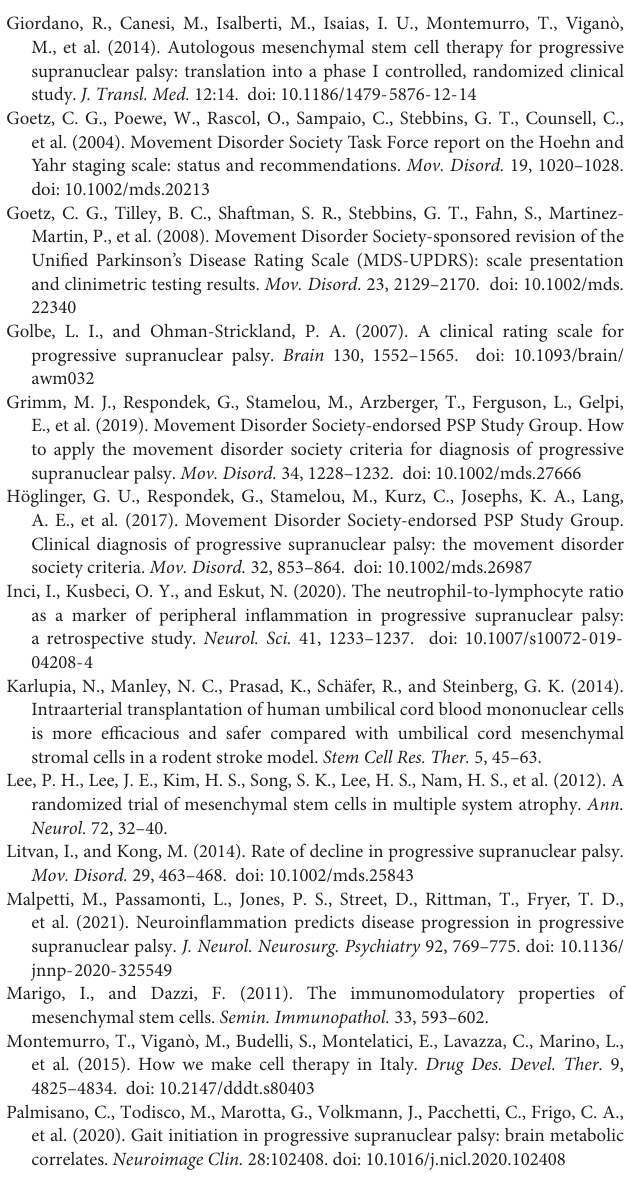
Supplementary Figure 1 | Serum cytokine levels in PSP patients before and after MSC administration. Dot plot diagrams comparing serum concentrations for each cytokine (Wilcoxon matched-pairs signed-rank test). (a) IL-6 ( p = 0.375), (b) IL-8 ( p = 0.5781), (c) TNF- α ( p = 0.2969), (d) IL-1 β ( p = 0.375), (e) IL-5 ( p = 0.125), (f) IL-10 ( p = 0.0938), and (g) IFN γ ( p = 0.0781). In one patient, the pre-treatment IL-5 serum concentration was below the quantification limit. Supplementary Table 1 | Individual patient data at each time point: demographical data, treatment details (administered cell dose and purity), baseline and follow-up neuropsychological assessments by Mini-Mental State Evaluation (MMSE) and clinical scoring, and serum cytokine level. n.a. = not available. Supplementary Table 2 | SPECT data ( n = 3). Specific striatal dopamine uptake transporter binding of [I-123] ioflupane. Binding was calculated for the left and right striatum, putamen, and caudate nucleus using the following formula, where ROI is the region of interest: [(mean counts in specific ROI) − (mean counts in occipital ROI)]/(mean counts in occipital ROI). n.a.: not available; L: left; R: